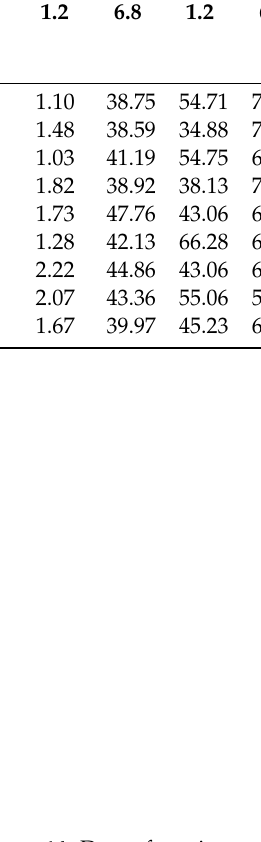
Figure 14. Data of ex vivo wash-off method to evaluate mucoadhesive properties of the optimized alginate beads containing BSO in pH 1.2 and pH 6.8 buffer media (mean ± SD, n = 3).